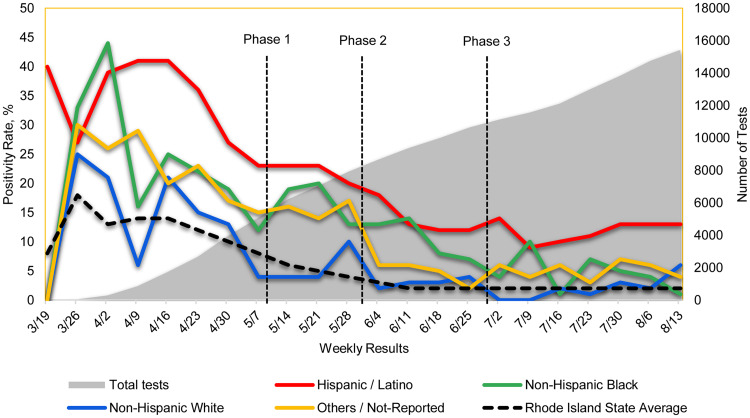
SARS-CoV-2 positivity rates at Providence Community Health Centers vs. the Rhode Island State average. The red line represents the per cent positivity of the Hispanic/Latino population over reopening phases 1−3 compared to other populations. The per cent positivity of the Hispanic/Latino population never dropped below 10%. The shaded grey area represents the total number of cumulative tests over time.